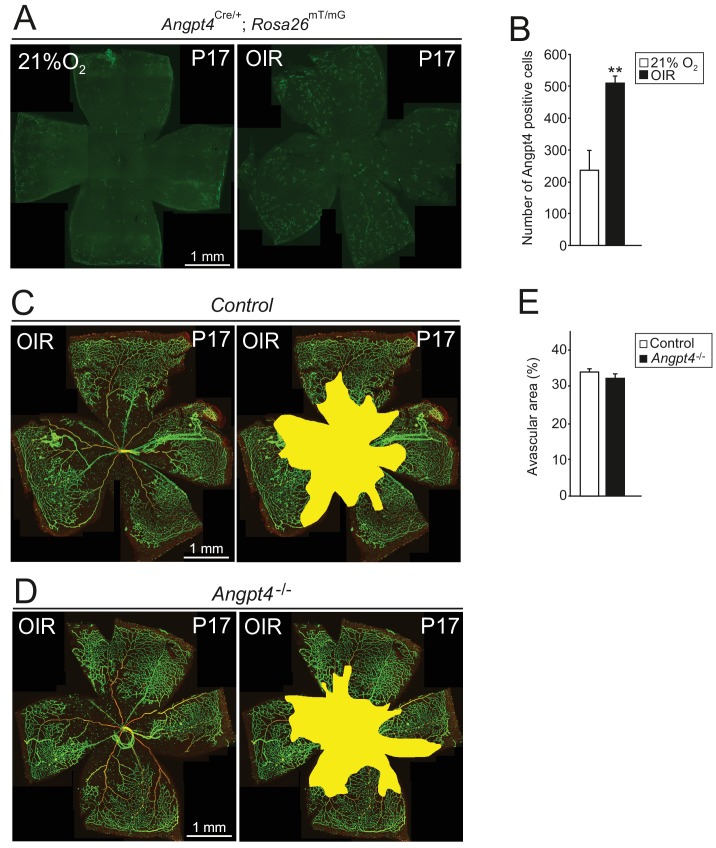
Induction of Angpt4 expression and degree of vasculopathy in OIR model in Angpt4-/- mice.In the oxygen-induced retinopathy (OIR) -model, P7 mice were exposed to 75% oxygen for 5 days and then returned to normoxia (21% O2) for 5 days, resulting in capillary dropout and retinal ischemia that are followed by capillary proliferation for neovascularization of avascular areas. (A) Angpt4 lineage cells (GFP, green) visualized in Angpt4Cre/+; Rosa26mT/mG reporter mice in flat mount retinas harvested at P17. (B) In OIR-model, number of GFP positive cells is increased compared to normoxia. (C–D) Whole mount retinal staining of OIR retinas, IB4 (green) and αSMA (red) staining visualize capillary-artery-vein hierarchy in the superficial layer. Avascular areas quantified in (E) are highlighted in yellow. Angpt4 deficiency does not affect neovascular tuft formation or capillary regeneration in avascular retina. (B) and (E) Quantification of image data; control n = 4 and OIR n = 2 mice (B); control n = 5 and Angpt4-/-
n = 4 mice (E). Mean ±SD, **p<0.01 in t-test.